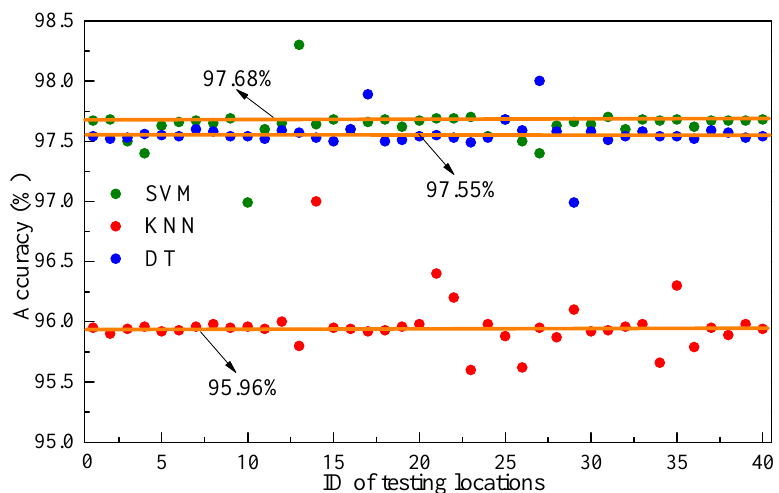
Figure 14. Accuracy of inter-floor